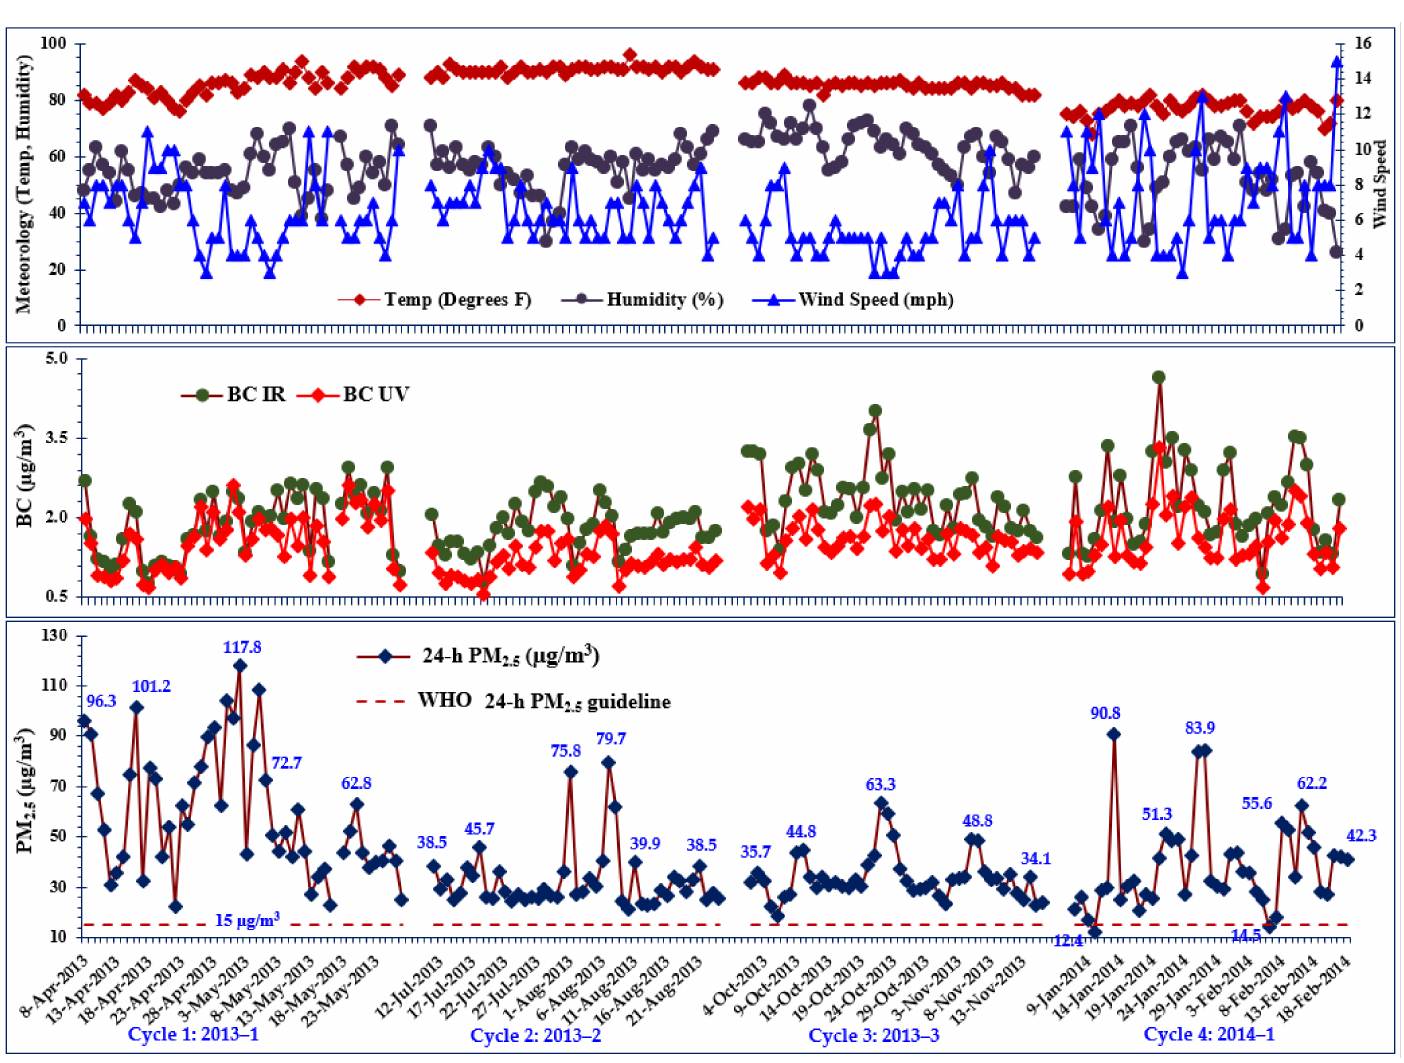
Figure 2. Time-series plots for the 24-h PM 2.5 , BC, and meteorology during the study period in Jeddah—averaged sampling